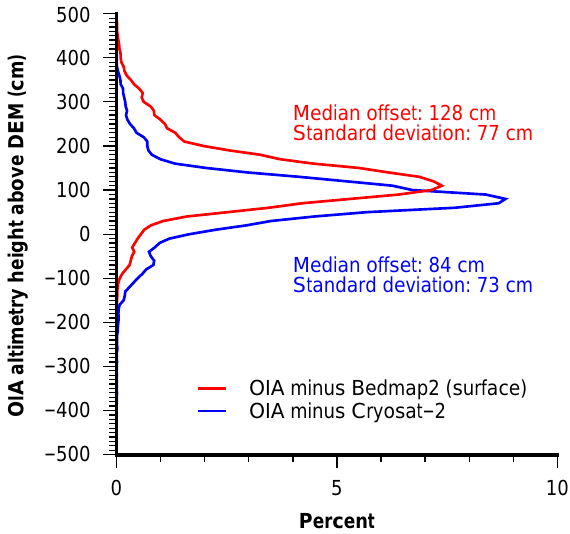
Figure 7. Histograms comparing two surface elevation DEMs (largely derived from radar altimetry) and OIA altimetry. Expected accuracy of OIA altimetry is 15cm (Young et al.,